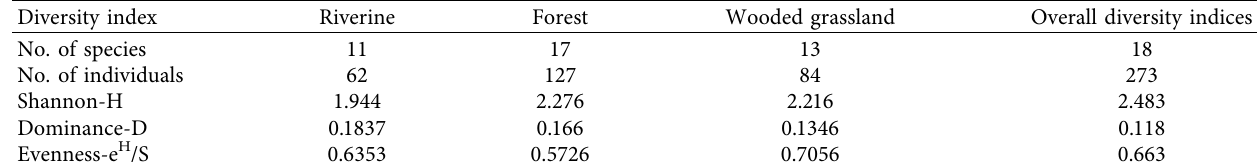
Figure 2: Some photo of mammals and their scat or spine observed during assessment. (a) Olive baboon, (b) grivet monkey, (c) mantled guereza, (d) porcupine scat, (e) civet scat, (f) hyena scat, and (g) scat observation. Table 2: Species diversity and evenness in Chimit-Kolla.